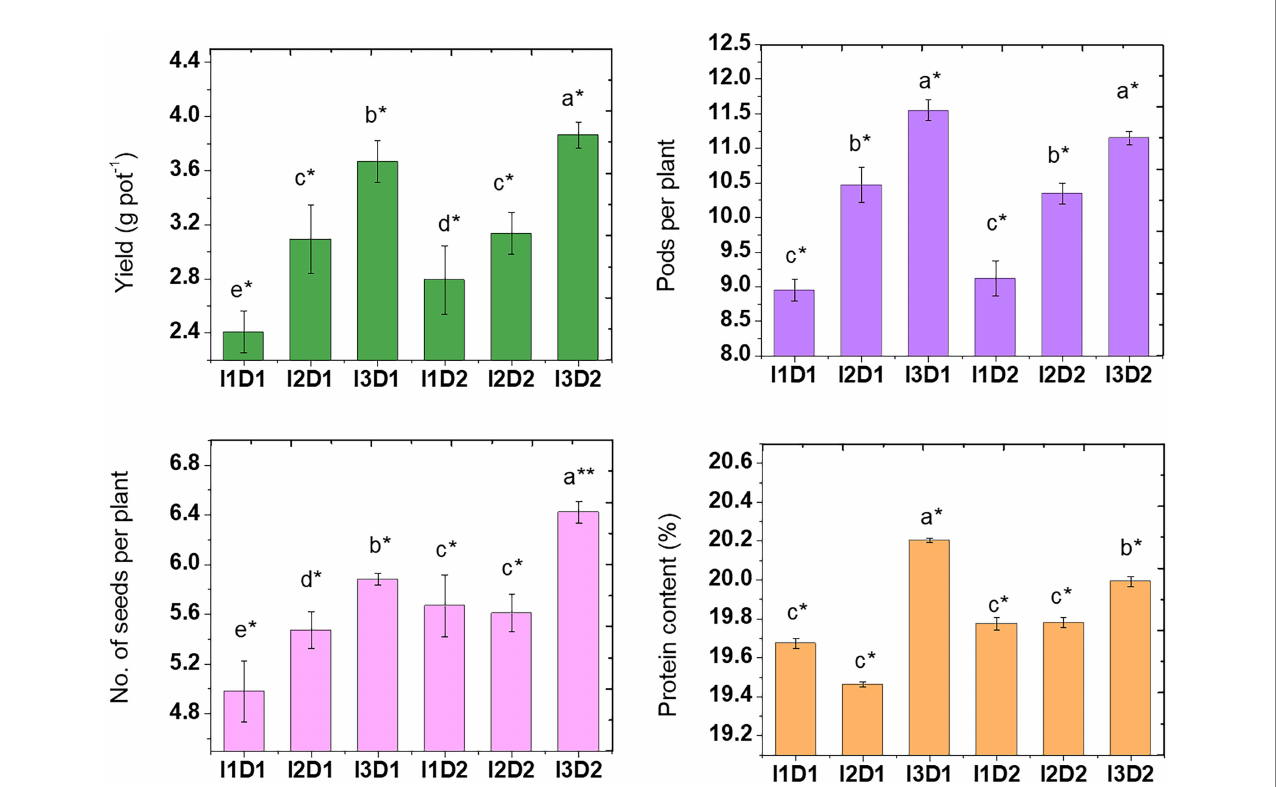
FIGURE 7 Effect of halotolerant microbial consortia dosage on yield quantity and quality of Vigna mungo L. under salinity. I 1 – Control; I 2 – Microbial consortium I; I 3 – Microbial consortium II and D 1 -2 kg of bioformulation per ha; D 2 -4 kg bioformulation per ha. Bars that do not share similar letters denote statistical significance. (* and ** denote significance at p < 0.05 and p < 0.01,